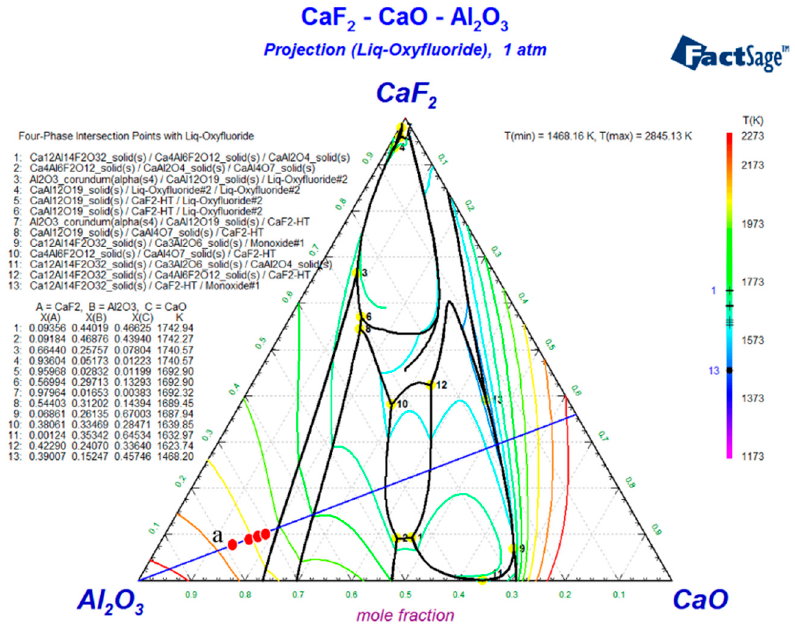
Figure 8. Ternary phase diagram of Al 2 O 3 –CaO–CaF 2 .